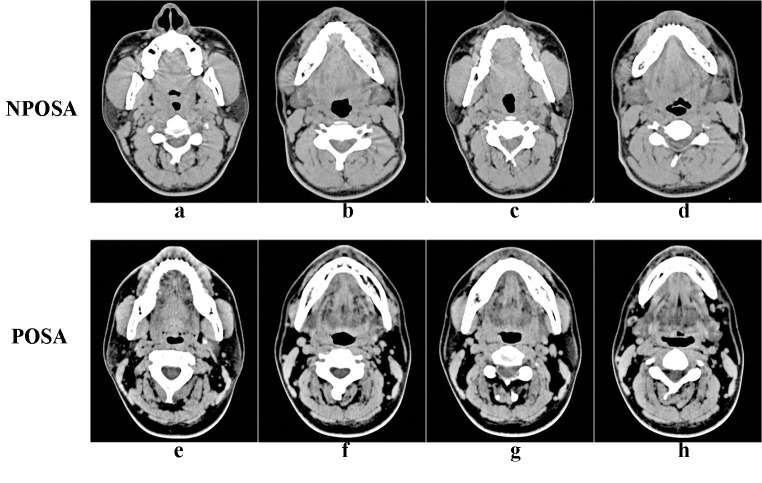
Cross-sectional views of the upper airway in the four planes in NPOSA (A–D) and POSA (E–H).NPOSA, non-positional obstructive sleep apnea; POSA, positional obstructive sleep apnea; (A), (E), cross-sectional views of the palatopharynx; (B), (F), cross-sectional views of the glossopharynx; (C), (G), cross-sectional views of the hypopharynx; (D), (H), the cross-sectional views of the narrowest part of the glossopharynx.